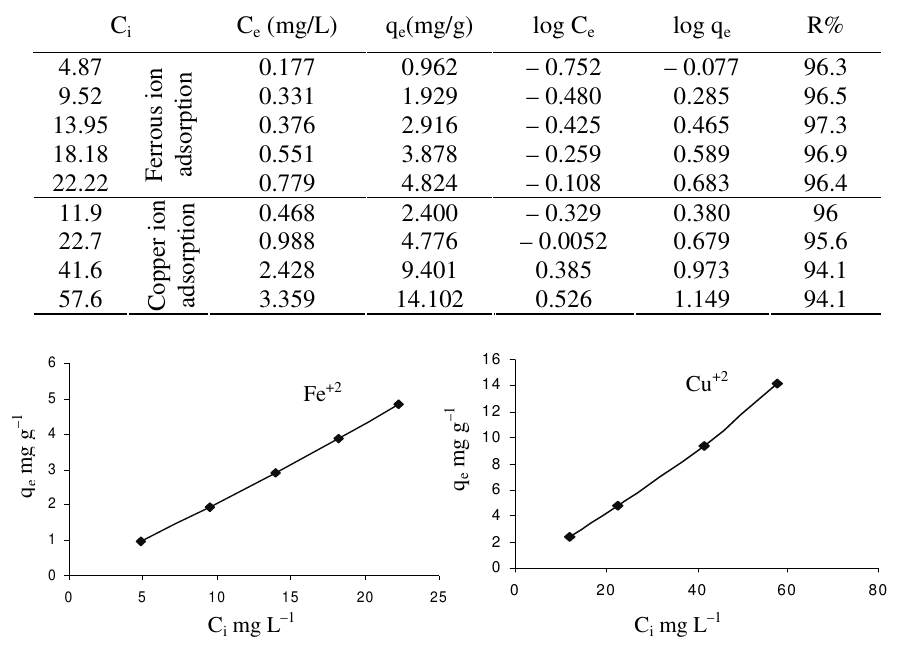
Figure 5 . Effect of initial concentration of metal ions on